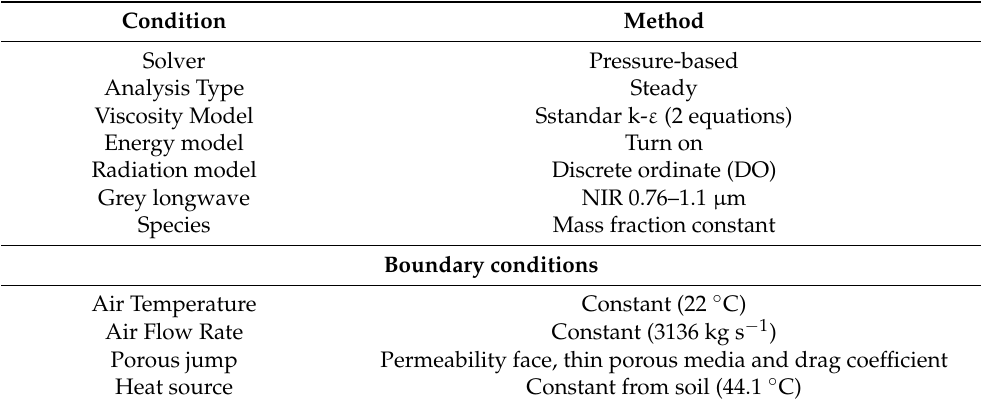
Table 3. Settings of the computational